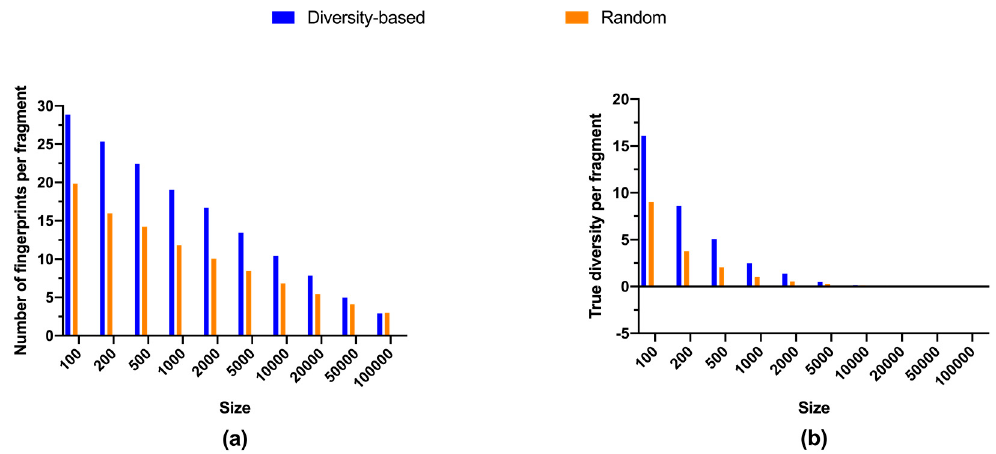
Figure 2. Efficiency in adding diversity: ( a ) average number of unique fingerprints (richness) per compound; ( b ) average value of true diversity per compound. Metrics for random selections are average values of triplicates. Table 1. Library sizes (diversity-based selection) required to achieve certain values of structural diversity.